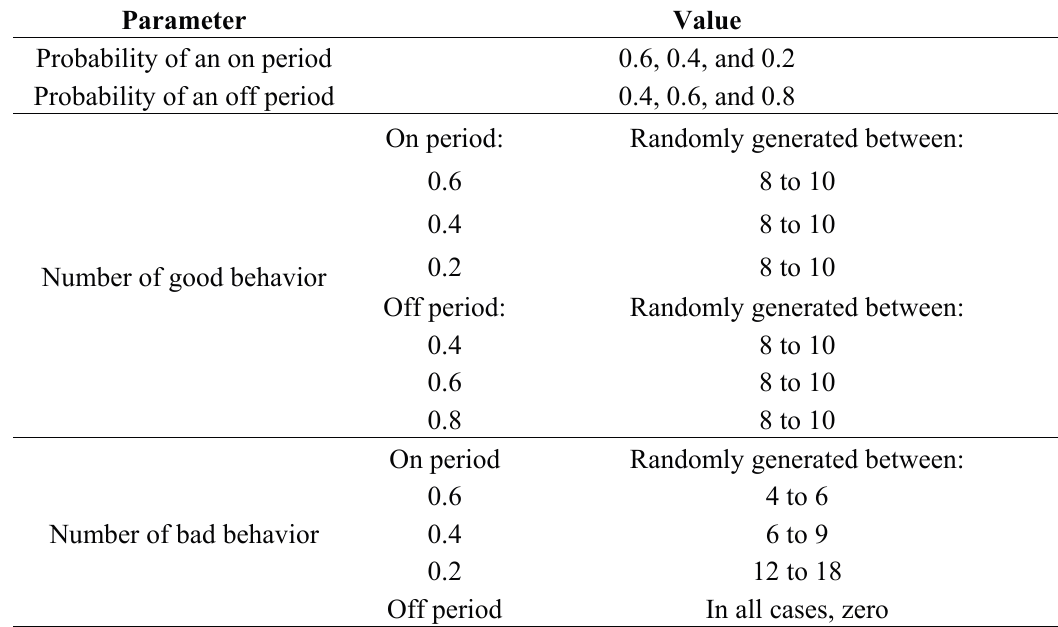
Table 4. Parameters to simulate an on-off